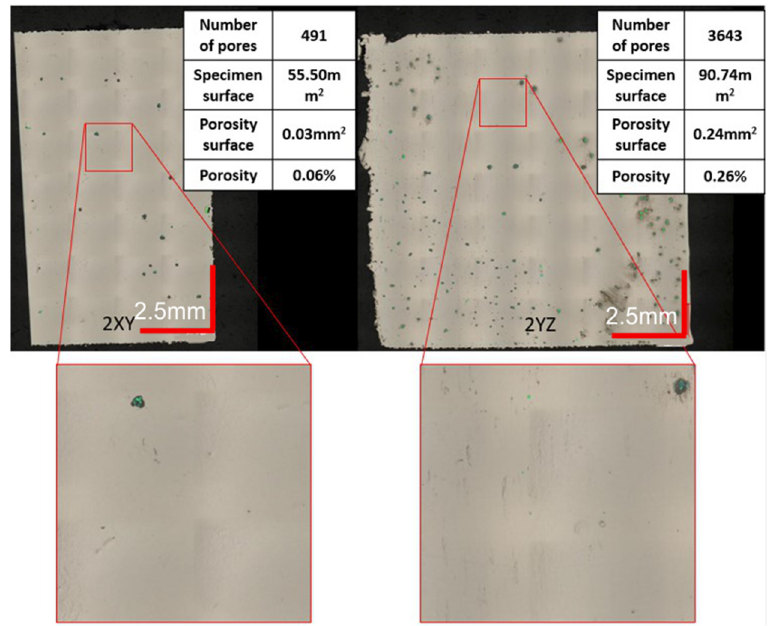
Figure 11. Evaluation of the porosity of a sample produced using 2 groups of parameters.